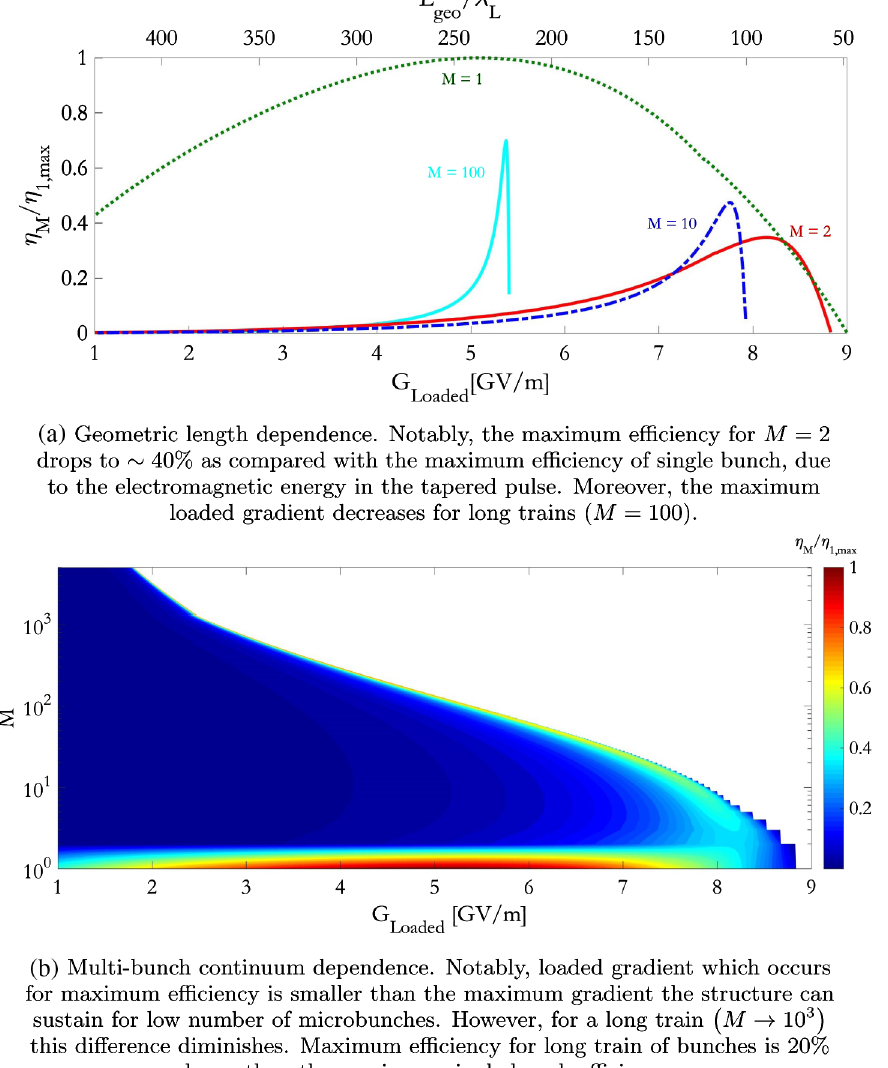
60 . 5% Þ as a function of the loaded gradient max ¼ as a function of M